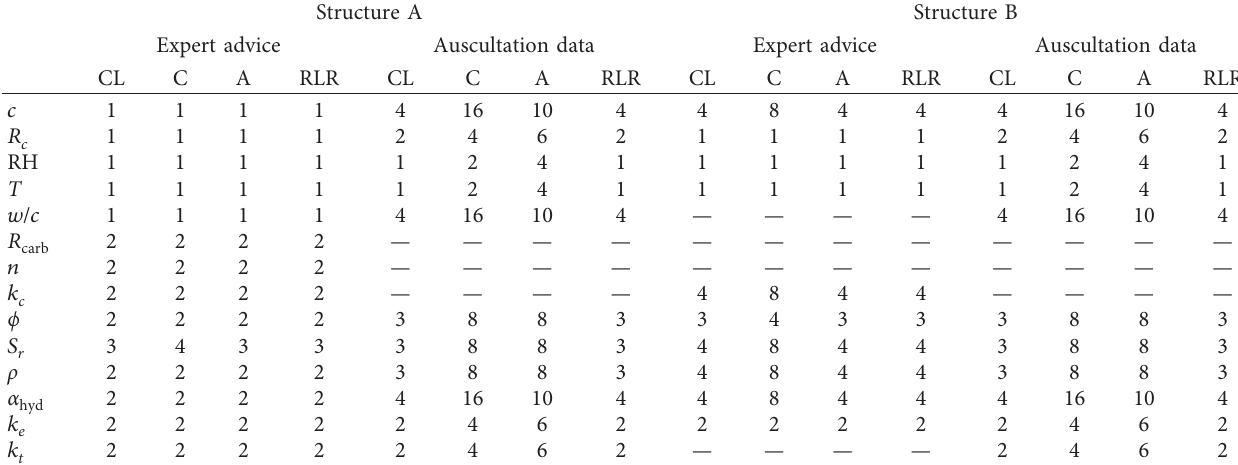
Table 16: Complexity level (CL), cost, accuracy level (A), and the level of robustness loss risk (RLR) with respect to structures A and B and for the input parameters of concrete carbonation